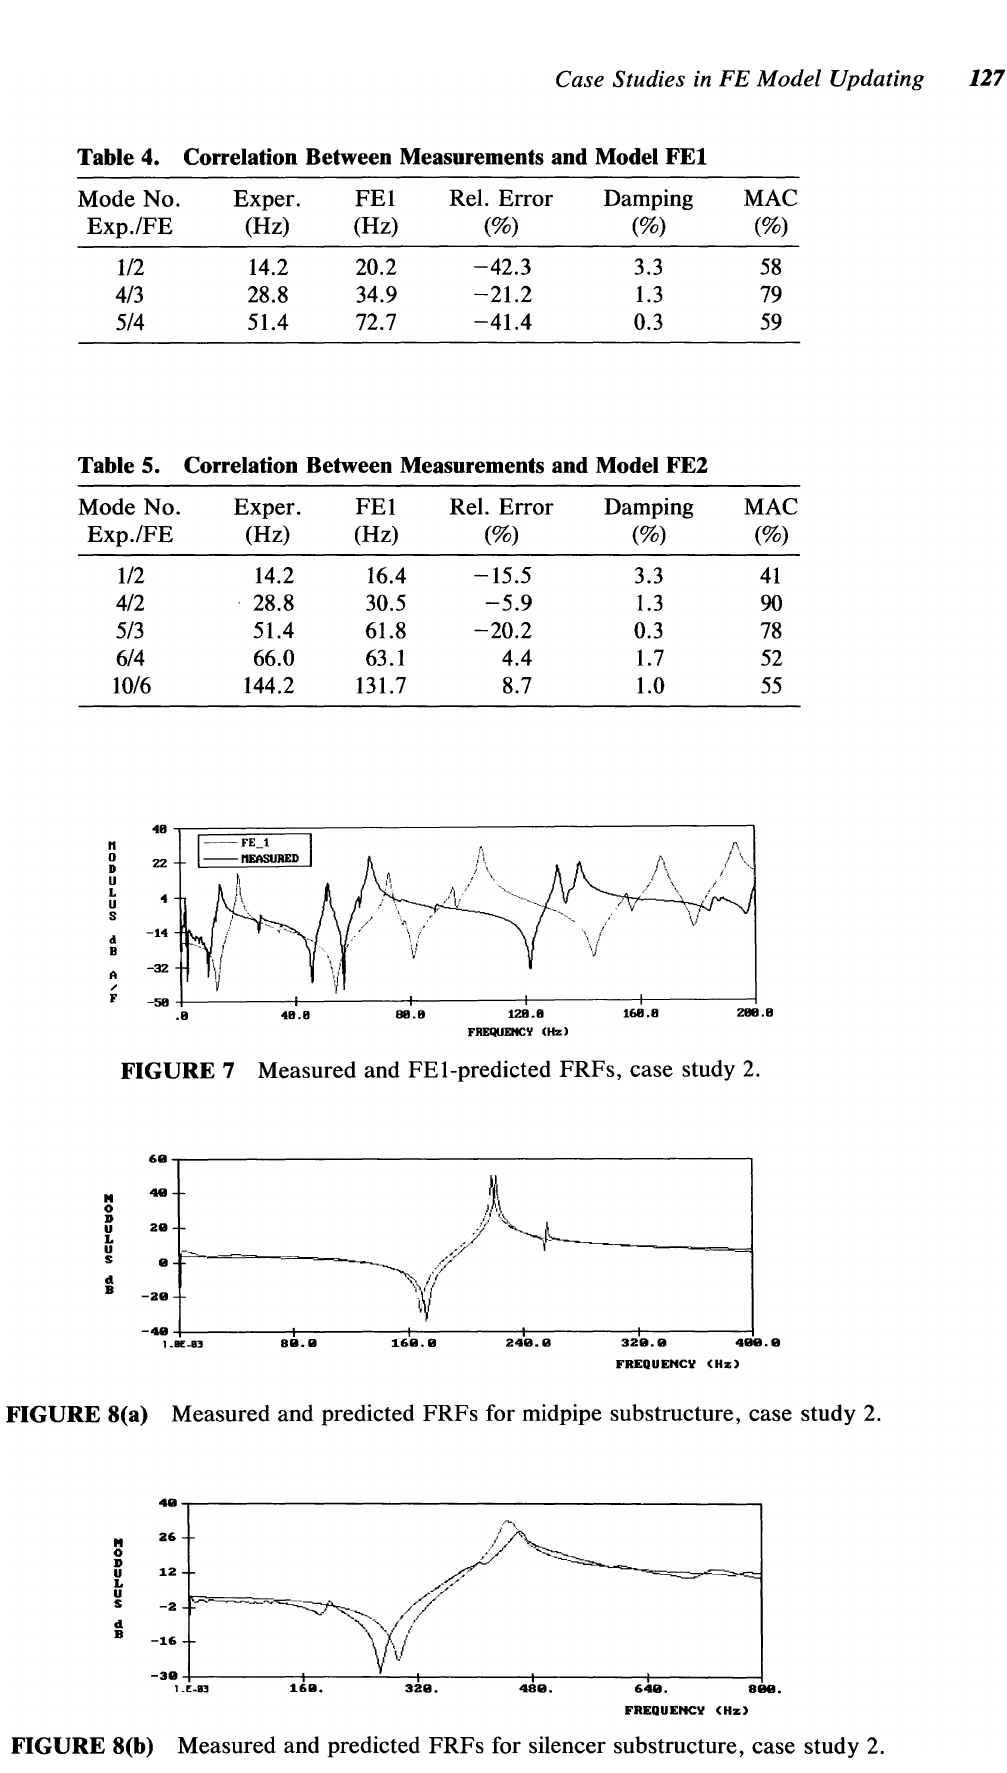
FIGURE 8(b) Measured and predicted FRFs for silencer substructure, case study